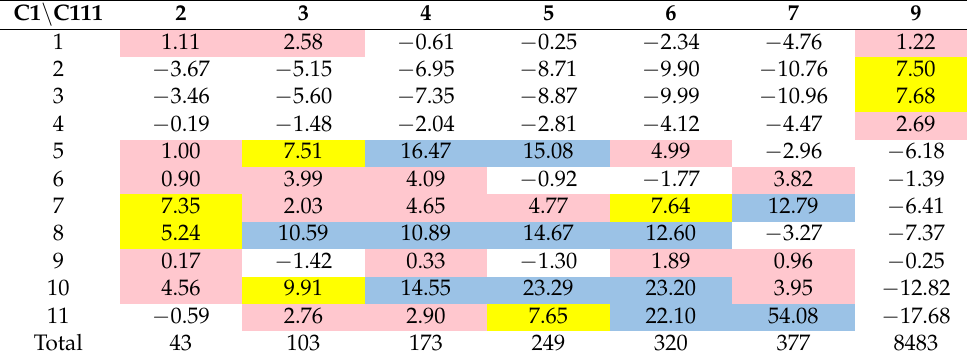
Table A2. Theoretical frequencies DUF 2018 (C1\c1121).